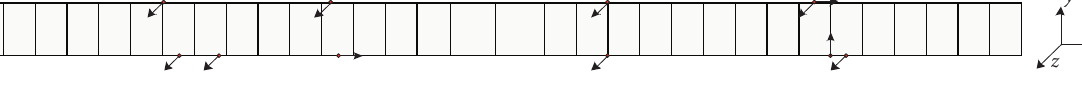
Figure 16: Optimal sensor placement of GA.